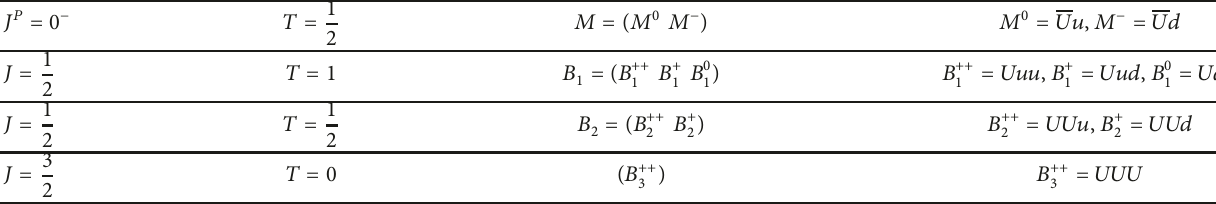
Table 1: Characteristics of 𝑈 -type hadrons.